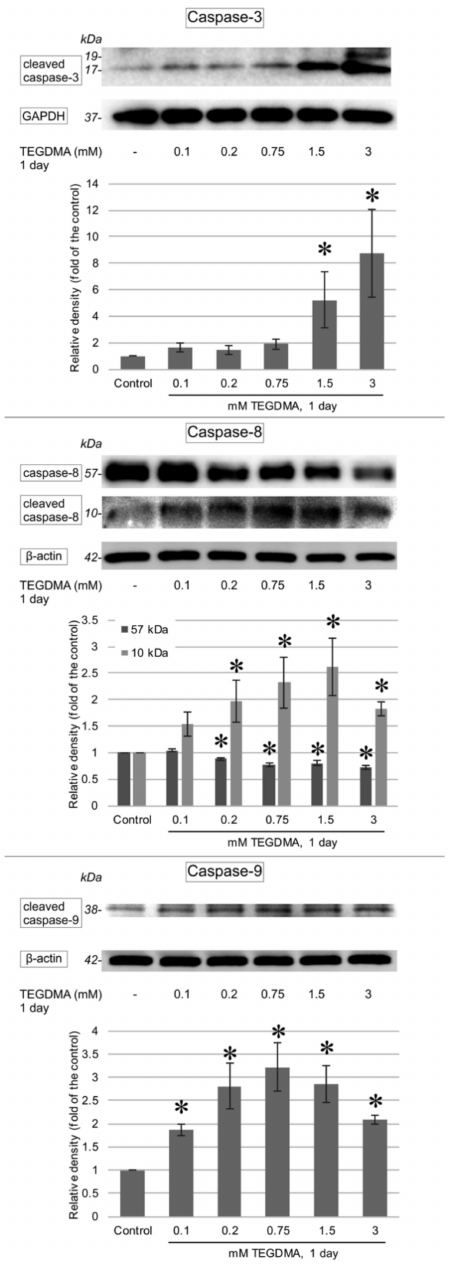
Figure 7. Immunoblots showing the changes in the levels of cleaved caspase-3, -8, and -9 in pulp cells after a 1-day exposure to 0.1, 0.2, 0.75, 1.5, and 3 mM TEGDMA. GAPDH or β -actin bands, obtained by reprobing the Western blot membrane, served as a loading control each time. Results of the quantitative analysis of densitometry data are illustrated below each blot (gathered by ImageJ). * = significantly different from the untreated control (in the case of the cleaved caspase-3 P = 0.0174 and P < 0.0001 at 1.5 mM and 3 mM, respectively; for the uncleaved caspase-8 P = 0.0002, P< 0.0001, P< 0.0001, and P< 0.0001 at 0.2 mM, 0.75 mM, 1.5 mM, and 3 mM, respectively; for the cleaved caspase-8 P = 0.0002, P < 0.0001, P < 0.0001, and P < 0.0001 at 0.2 mM, 0.75 mM, 1.5 mM, and 3 mM, respectively; in the case of the cleaved caspase-9 P = 0.0208, P < 0.0001, P < 0.0001, P < 0.0001, and P = 0.0035 at 0.1 mM, 0.2 mM, 0.75 mM, 1.5 mM, and 3 mM, respectively, sample number: n =